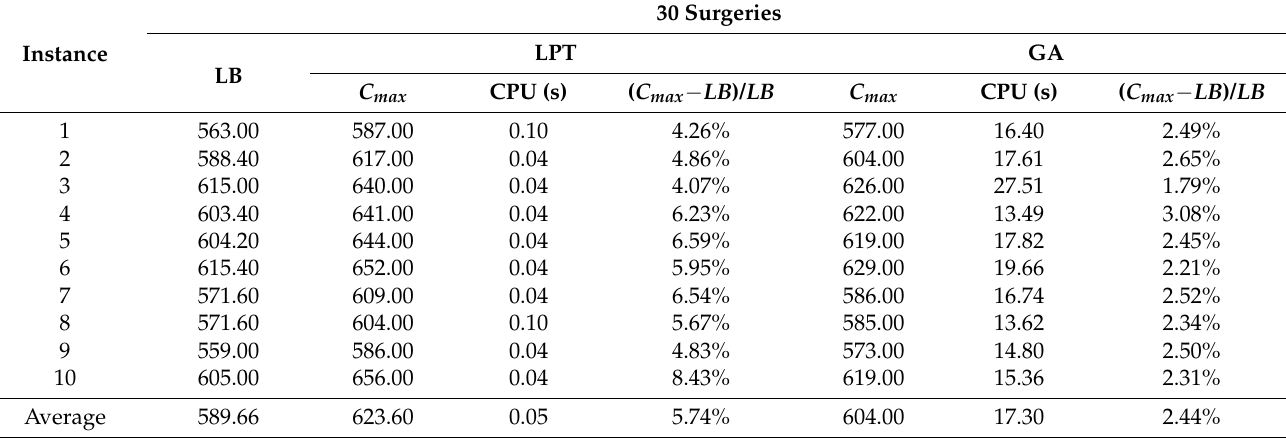
Table 8. Results of 30 surgeries.